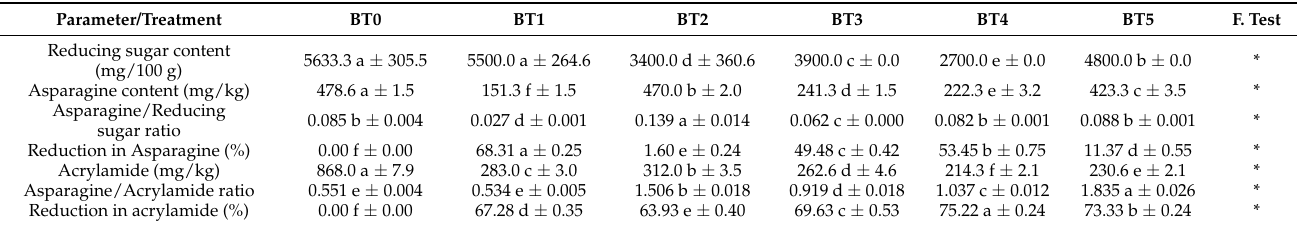
Table 3. Chemical parameters for processed